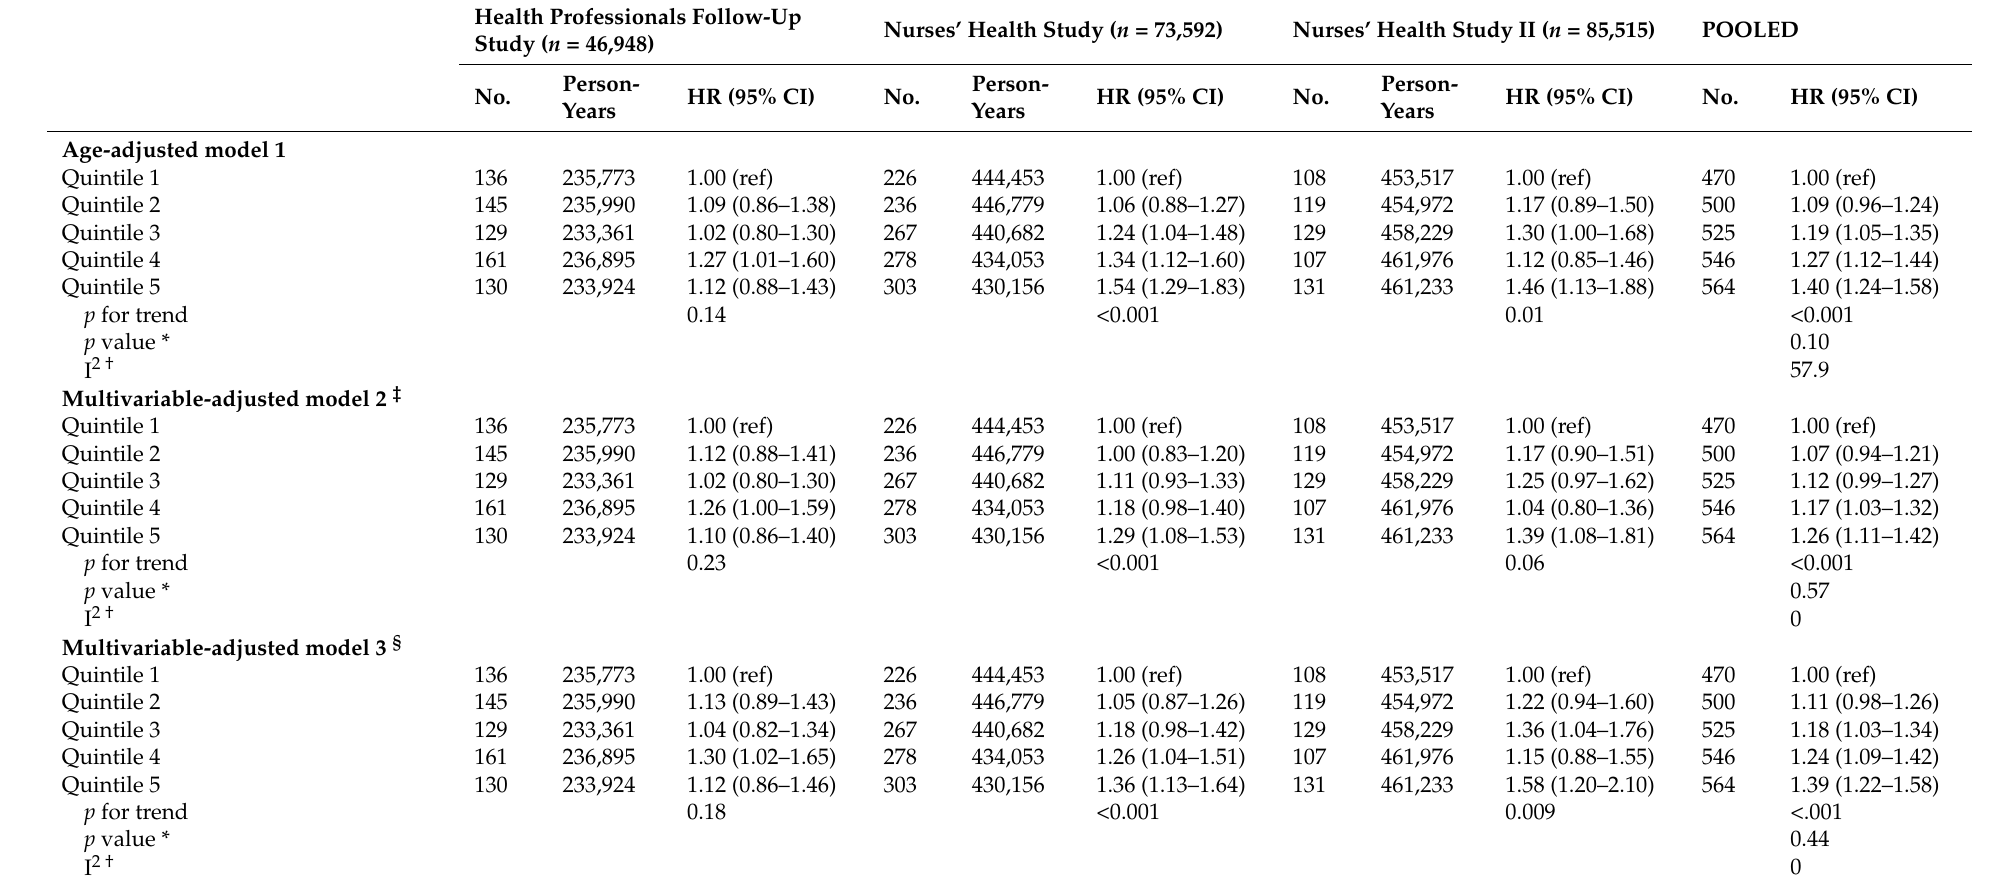
Table 4. Association between the unhealthful Plant-based Diet Index (uPDI) and the risk of newly-diagnosed chronic obstructive pulmonary disease in three cohorts of U.S.